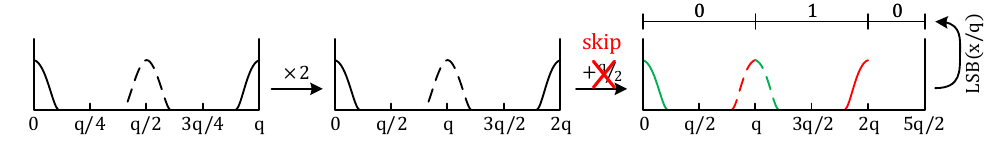
Figure 8: Visualization of Kyber’s decoding routine if we skip the addition of q/ 2. Parts of the distribution shown in green are still correctly decoded, despite the fault injection (ineffective fault). Red parts are incorrectly decoded (effective